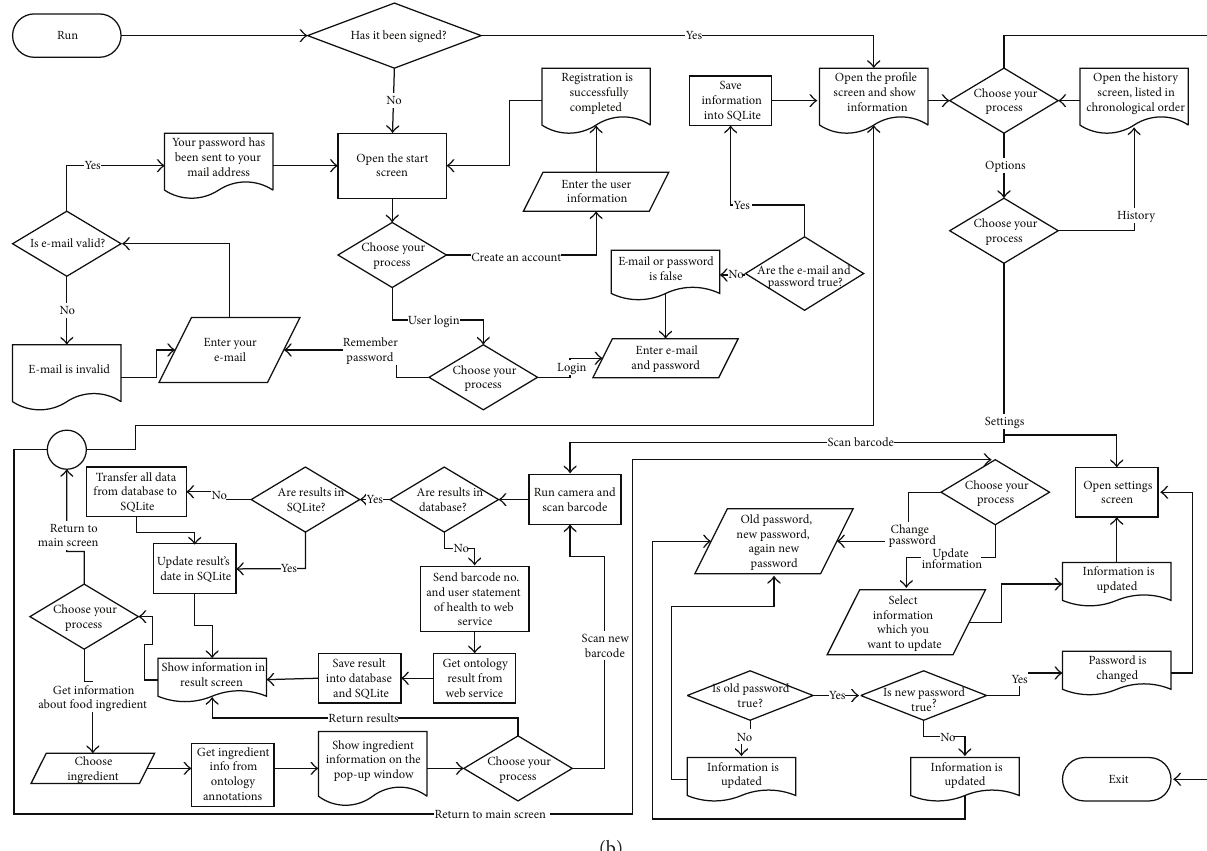
Figure 9: (a) Class diagram of FOKB. (b) Flow diagram of FoodWiki mobile